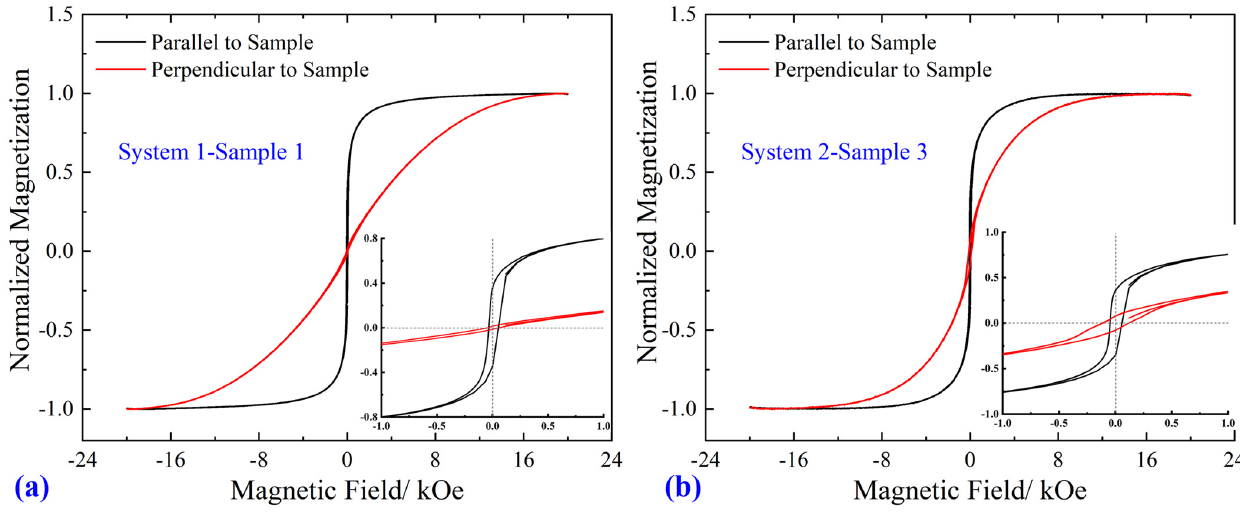
Figure 5. Hysteresis loops of di ff erent samples measured by VSM at room temperature: ( a ) system 1–sample 1; ( b ) system 2–sample 3. The insets in ( a , b ) are the partial enlarged pa tt erns at magnetic fi eld intensity from − 1.0 to 1.0 kOe.